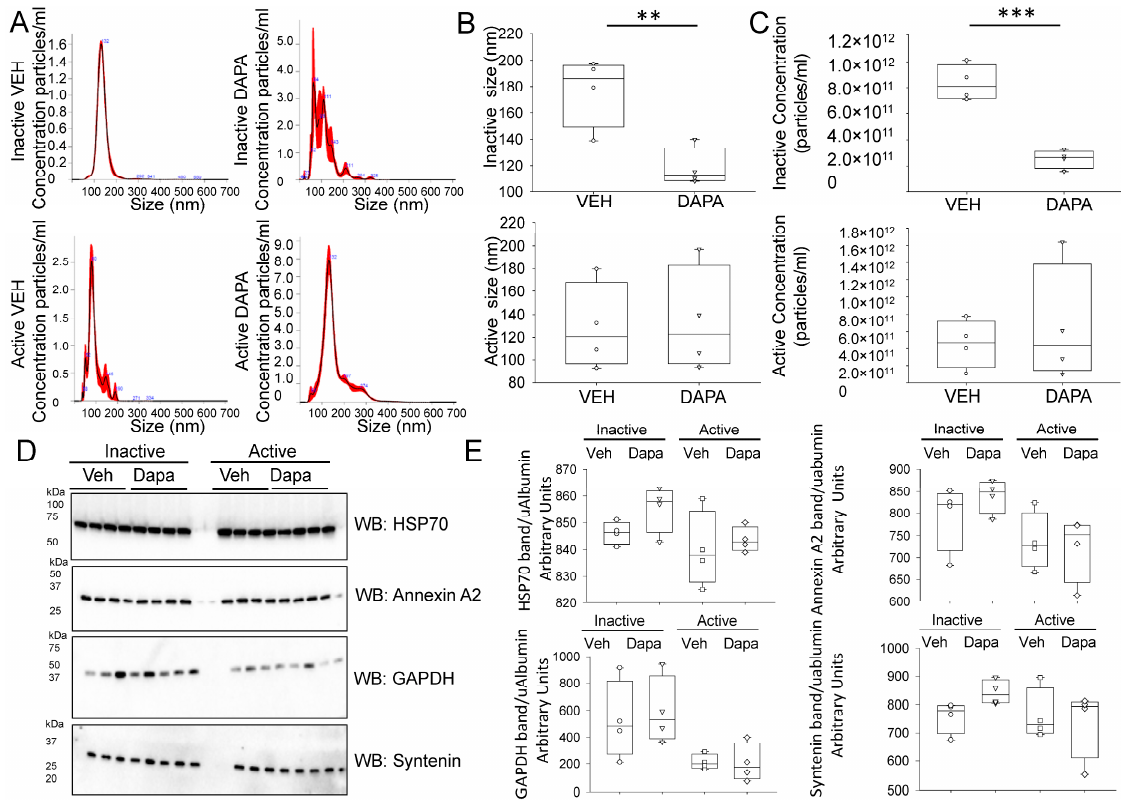
Figure 4. Characterization of uEVs isolated from the inactive and active phases of salt-loaded hypertensive diabetic db/db mice. ( A ) Representative nanoparticle tracking analysis plots of uEVs isolated from diabetic db/db mice treated with vehicle or dapagliflozin during the inactive or active phases. ( B ) Summary plots showing the comparison of uEV size between the two groups and two phases. ** represent a p -value of <0.01 ( C ) Summary plots showing the comparison of uEV concentration between the two groups and two phases. *** represent a p-value of <0.005 ( D ) Western blots of established uEV markers in each uEV sample from the two groups and phases. n = 4 uEV preparations from inactive-phase urine collections and the same number of uEV preparations from active-phase urine collections of n = 4 vehicle-treated db/db mice and n = 4 dapagliflozin-treated db/db mice. ( E ) Densitometric analysis of the immunoreactive bands in Panel D normalized to urinary albumin levels (uAlbumin).